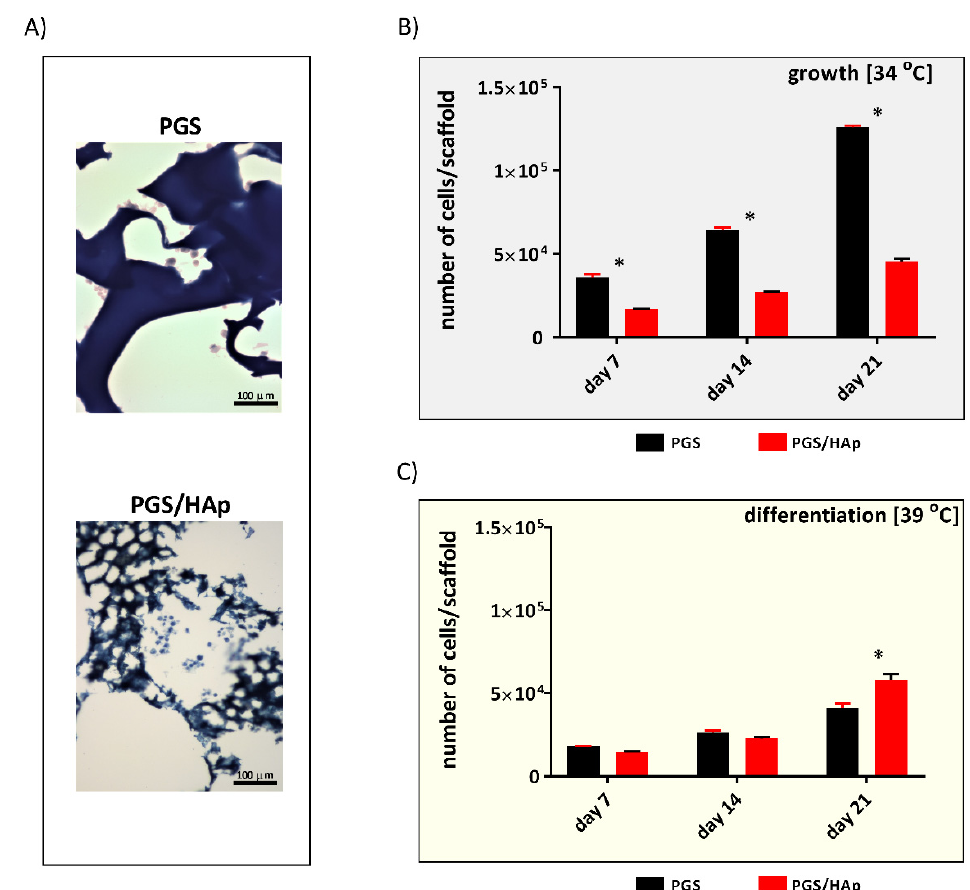
Figure 9. Optical microscopic images of May–Grunwald–Giemsa stained sections of the PGS and PGS/HAp scaffolds populated by hFOB 1.19 pre-osteoblasts in 7-day cell cultures ( A ). The nuclei of the cells appeared deep purple with light purple surroundings. The proliferation of human osteoblasts in the PGS and PGS/HAp scaffolds ( B ) under conditions permitting proliferation (34 ◦ C) and ( C ) in the osteogenic conditions (39 ◦ C) followed for up to 21 days of culture. The results are shown as the mean values ± SD. * p < 0.05 between the PGS and PGS/HAp composites, with the Mann–Whitney U test used to assess the statistical significance for the observed